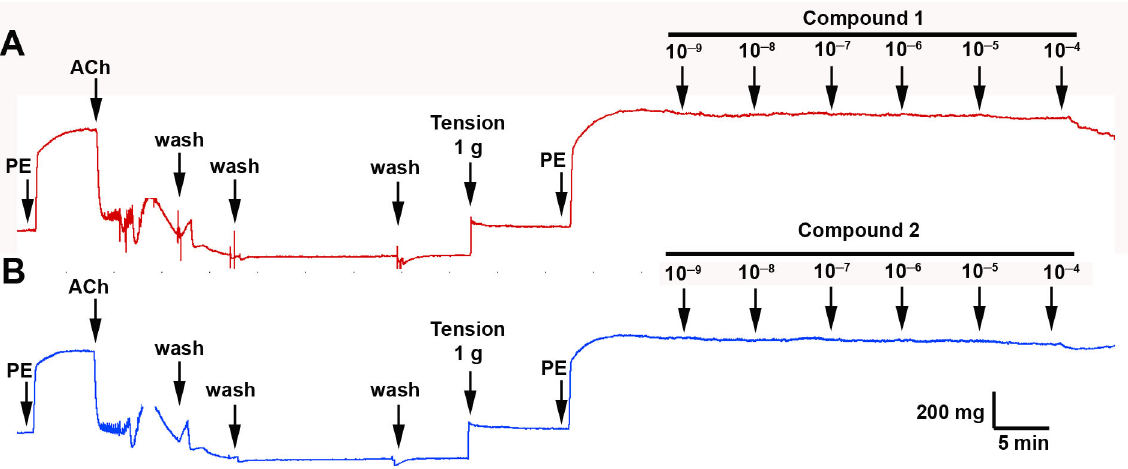
Figure 5. Compounds 1 and 2 do not cause vascular relaxation in the intact aorta. The original record of the vascular effect of compounds 1 ( A ) and 2 in rat aorta ( B ). The tissue was pre-contracted with 10 − 6 M PE, and then, the rising concentrations of compound 1 or 2 (10 − 9 –10 − 4 M) were added to the bath. Three independent experiments were performed.